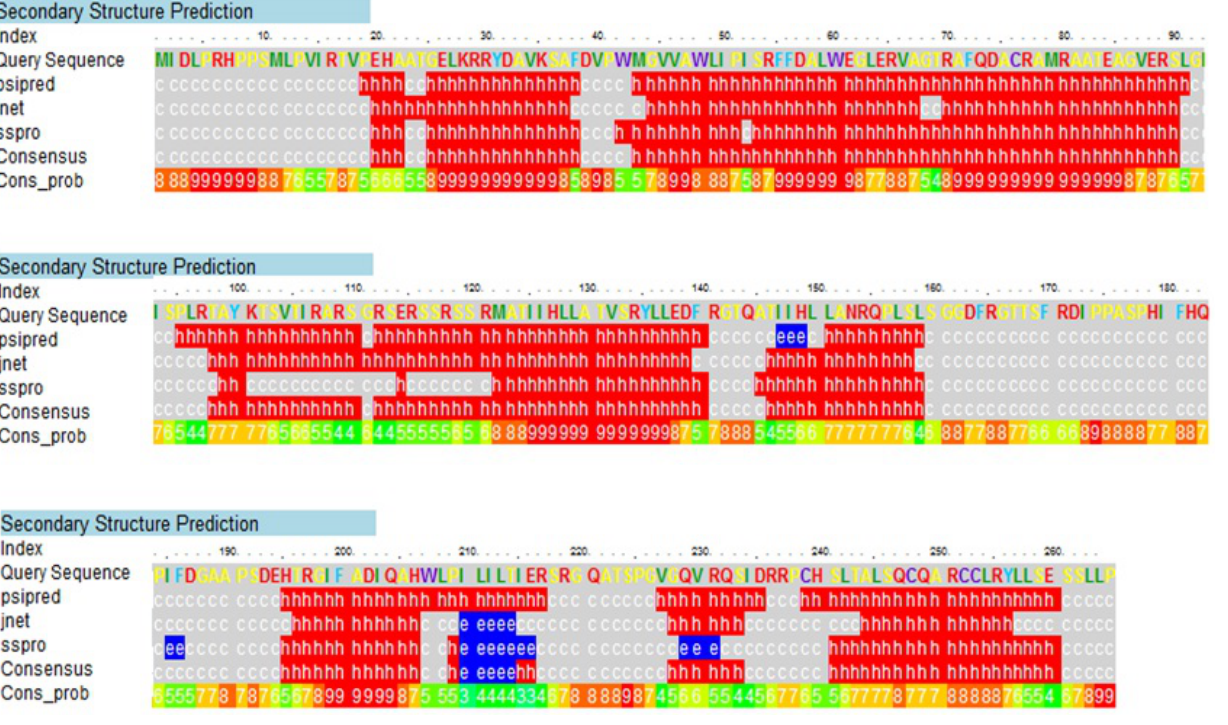
Figure 2. Secondary structure of DehD. N -terminal is shown in blue and C-terminal in